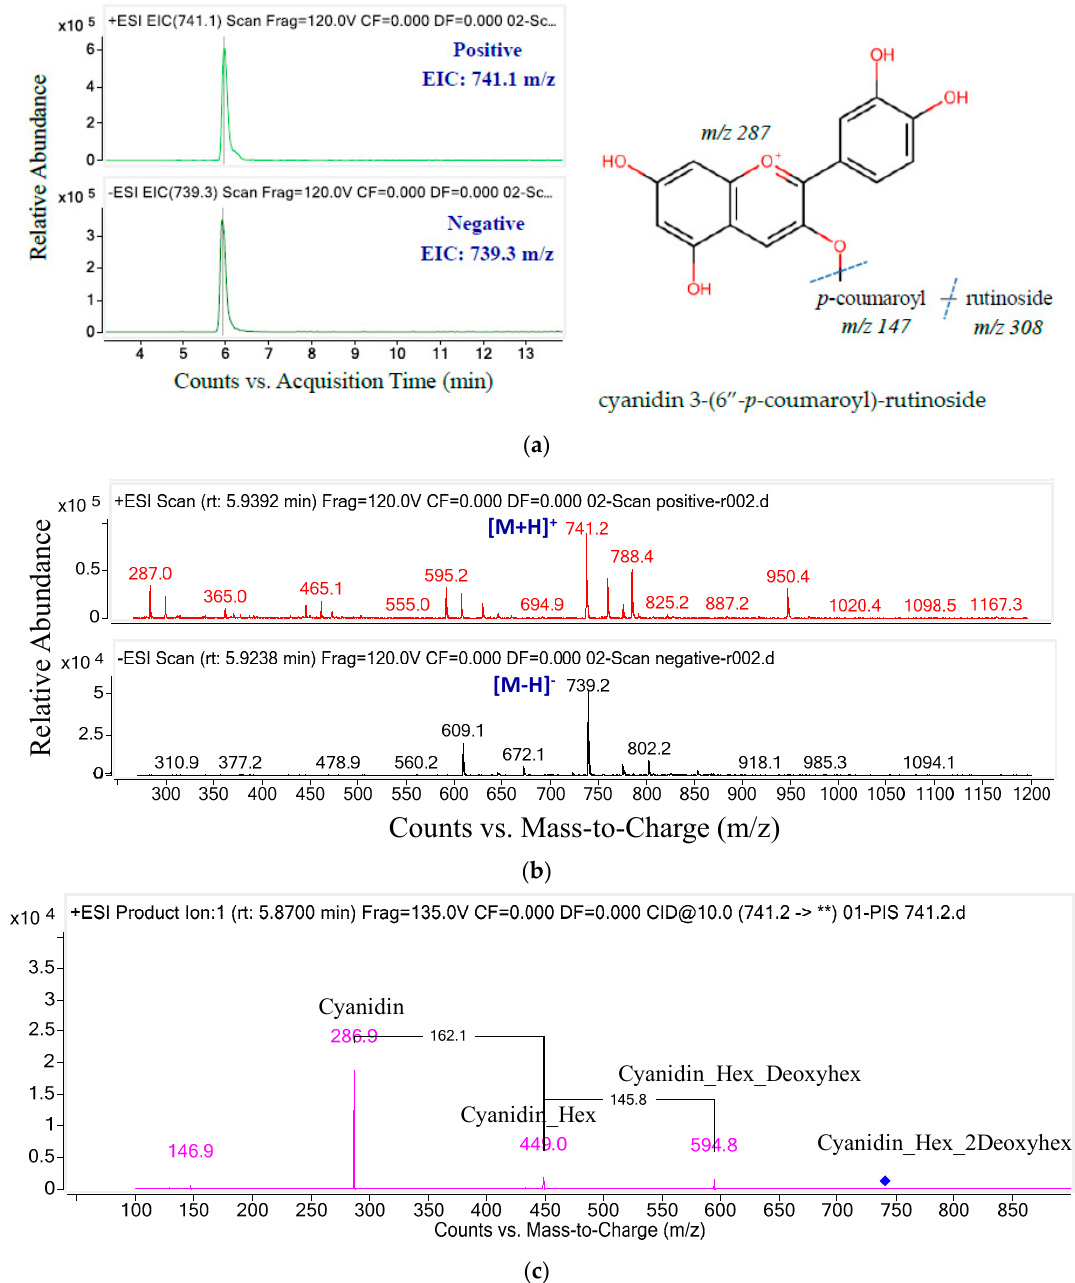
Figure 4. The ion chromatograms ( a ) and ion spectra ( b ) and MS/MS fragments (**) of parent mass 741.2 ( c ). Three peaks can be observed in the chromatogram in the positive ion mode, but only two in the negative ion mode (Figure 5). That means that the third anthocyanin has two isomers. Peaks 1 and 2 have the same daughter fragment of delphinidin aglycone ( m / z 302.9 and 302.8). In peak 1, the m / z transition from 464.4 to 302.9 indicates a loss of glucose. Meanwhile, peak 2 produces the main fragment, m / z 146.7, corresponding to p -coumaroyl. In addition, because the cis - p -coumaroyl derivative has a higher polarity, it elutes earlier